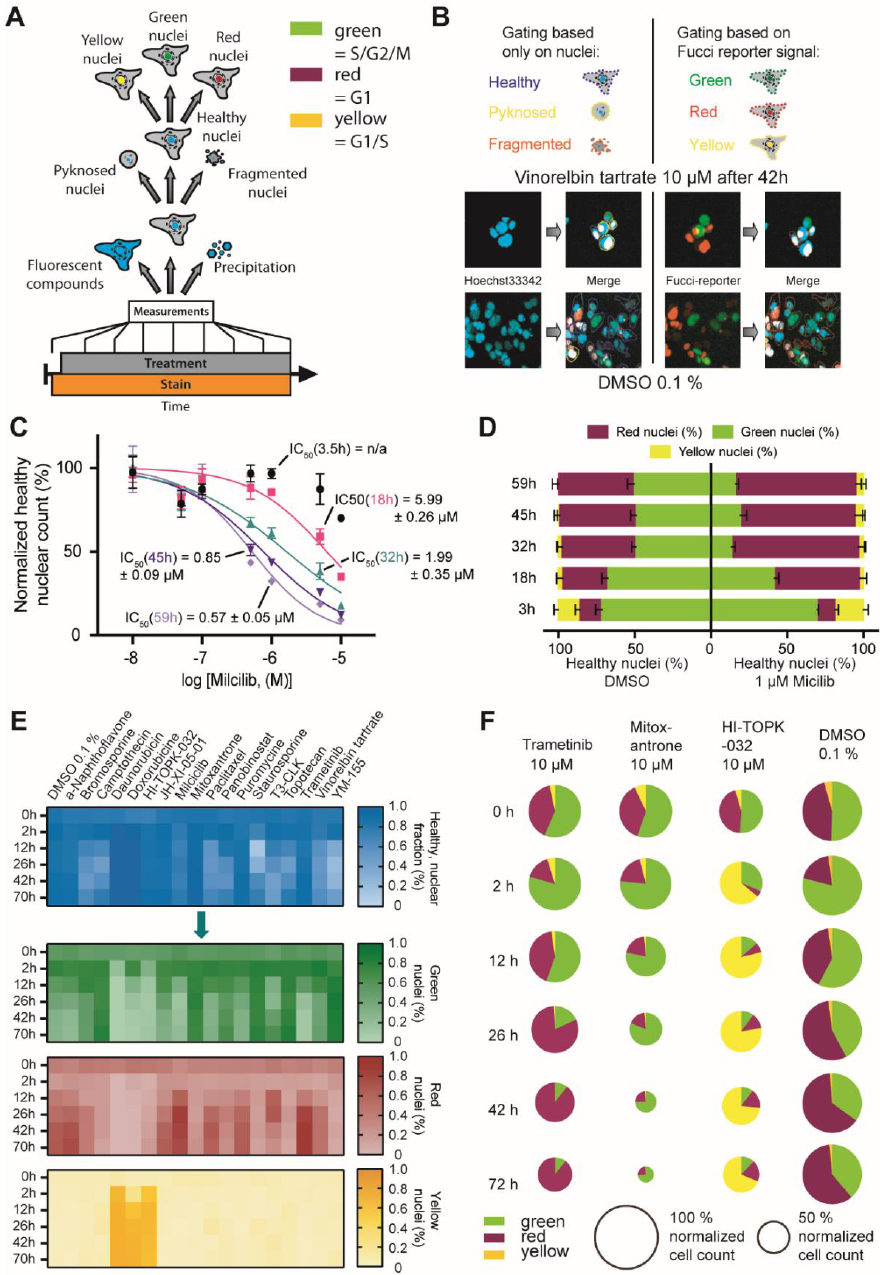
Figure 3. FUCCI Cell Cycle Assay. ( A ) Gating scheme of the machine learning-based analysis of the HCT116-FUCCI reporter cell line ( B ) Example images of HCT116 cells treated either with 10 µ M vinorelbine tartrate or 0.1% DMSO for 42 h. Highlighted by colored lines are the gating results of both the nuclear gating step into “healthy”, “pyknosed” and “fragmented” nuclei and the FUCCI gating step of ‘healthy’ nuclei only. ( C ) Cytotoxicity of milciclib for HCT116-FUCCI at different time points assessed by the normalized healthy cell count. The depicted IC50 values are the average and SEM of two independent experiments. ( D ) Population distribution of ‘healthy’ gated (based on nuclear features) HCT116-FUCCI cells treated with 1 µ M milciclib or 0.1% DMSO for different periods. ( E ) Heat map analysis of HCT116-FUCCI cells treated with 10 µ M of different inhibitor for different time points. ( F ) Detailed representation of the population fractions of HCT116-FUCCI cells exposed to 10 µ M of trametinib, mitoxantrone and HI-TOPK-032. The size of the pie charts reflected the normalized cell count. For comparison, the fractions of DMSO are shown as